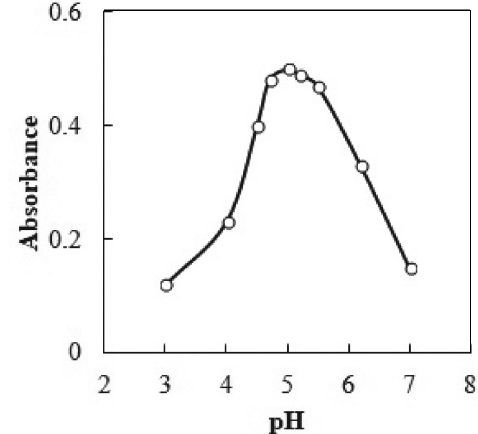
Fig. 2. Effect of pH on the extraction: 3.33 × 10 –5 mol/dm 3 of DH- DPhB, 5 × 10 –7 mol/dm 3 of Cu(II), V Chloroform = 1 cm 3 , λ = 570 nm.